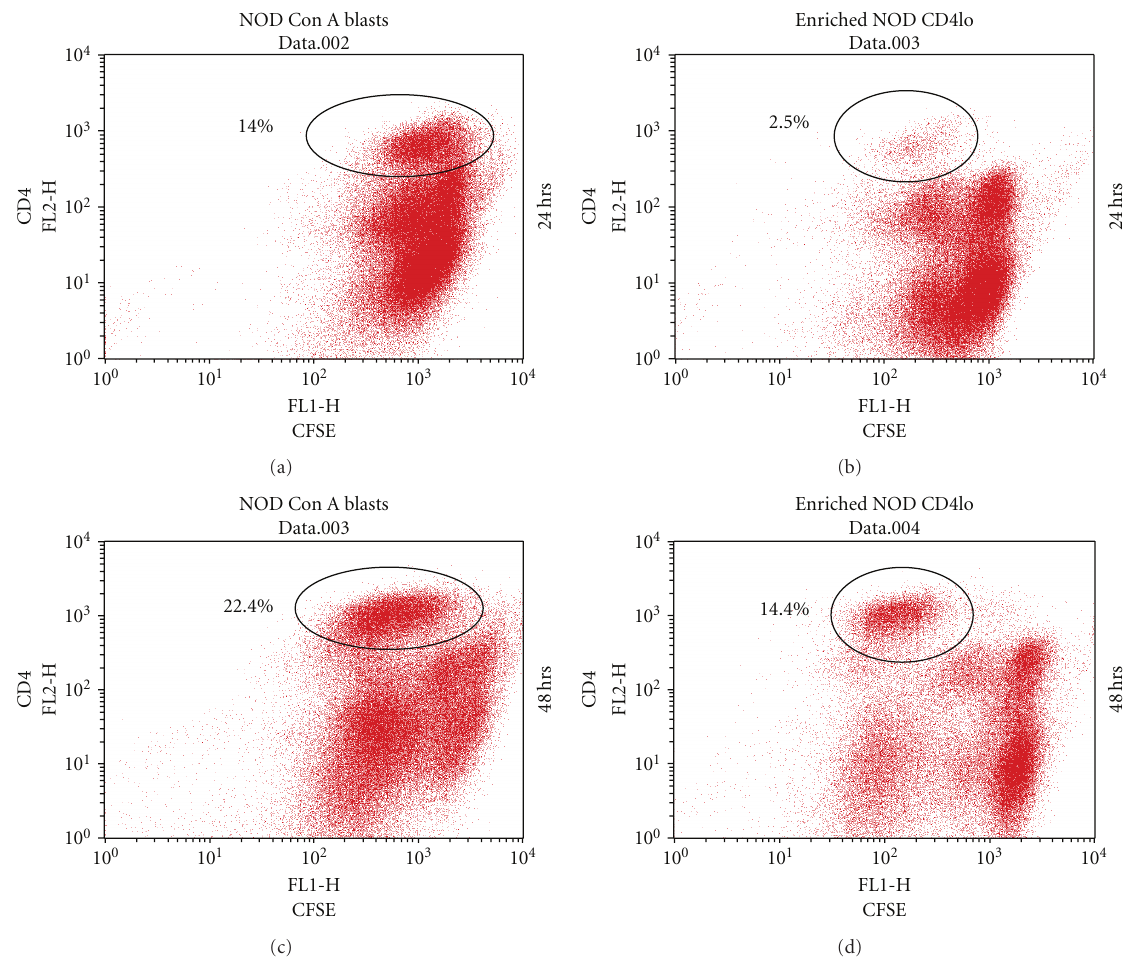
Figure 7: Antigen-experienced “CD4lo” T cells give rise to “CD4hi” T cells. “CD4lo” T cells were enriched from the Con A blasts of NOD spleen cells as described in Figure 6. The “CD4lo” T cells or Con A blasts were cultured overnight in IL-2-containing complete medium, then each was labeled with CFSE before incubation on anti-CD3-coated plates. Twenty-four and 48hrs later the cells were labeled with anti-CD4- PE and analyzed by flow cytometry to reveal cell divisions. Proliferating “CD4hi” T cells arising from the blasts are indicated in the encircled population the numbers indicate the percentage in the total cell population. For each analysis, 100,000 events were collected, and the results are representative of four